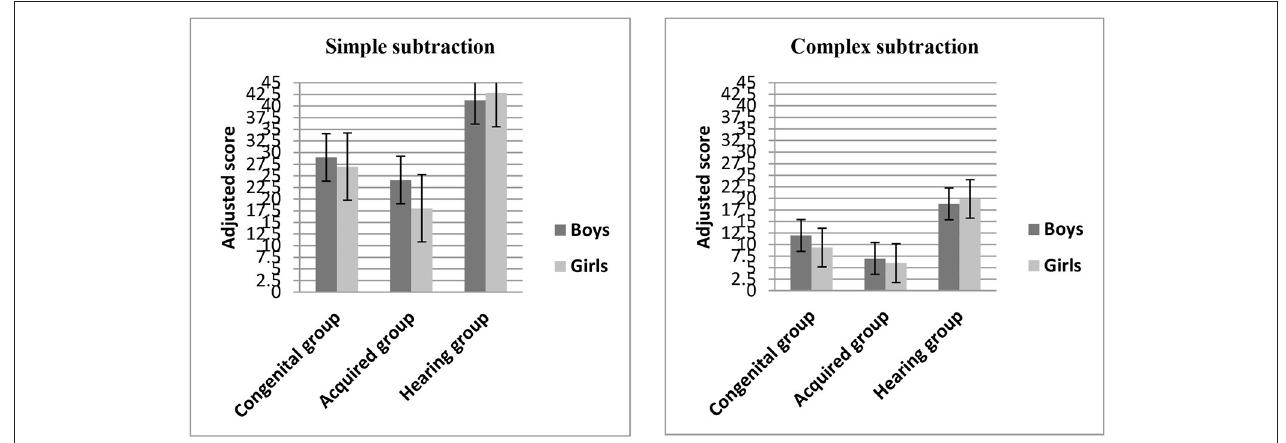
FIGURE 3 | Mean adjusted scores on the arithmetic computation tasks (simple and complex subtraction) across